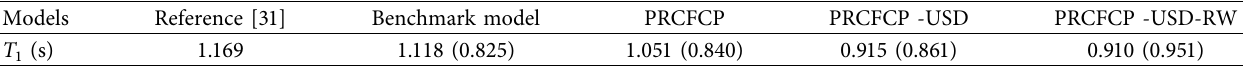
Table 1: Periods of all models (the values in brackets are the modal mass participating ratios). Models